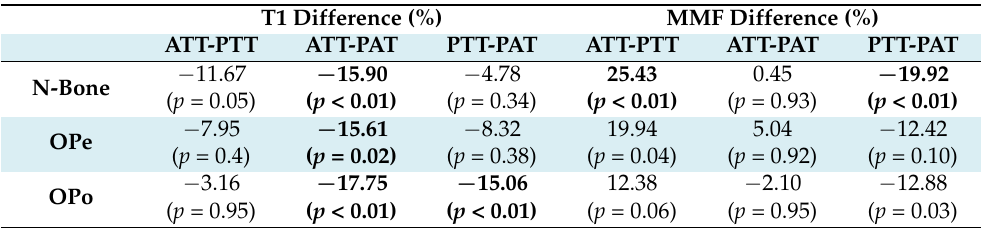
Table 3. Average percentage differences as well as Kruskal–Wallis test results of T1 and MMF between ATT, PTT, and PAT tendons. N-Bone label refers to Normal-Bone group.